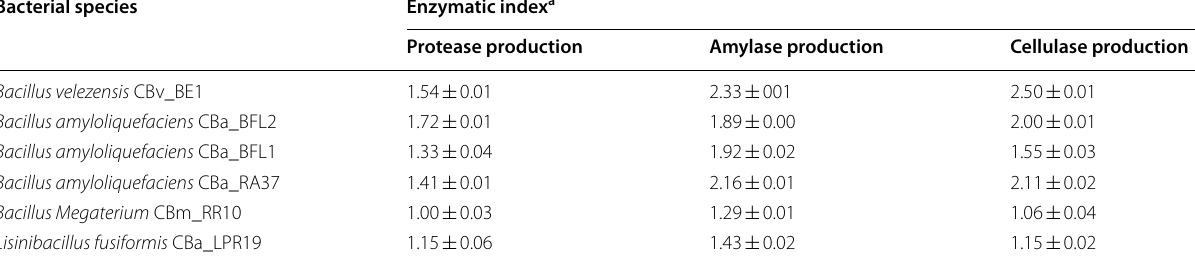
a Stands for mean diameter of halo zones with reference to the bacterial colony diameter